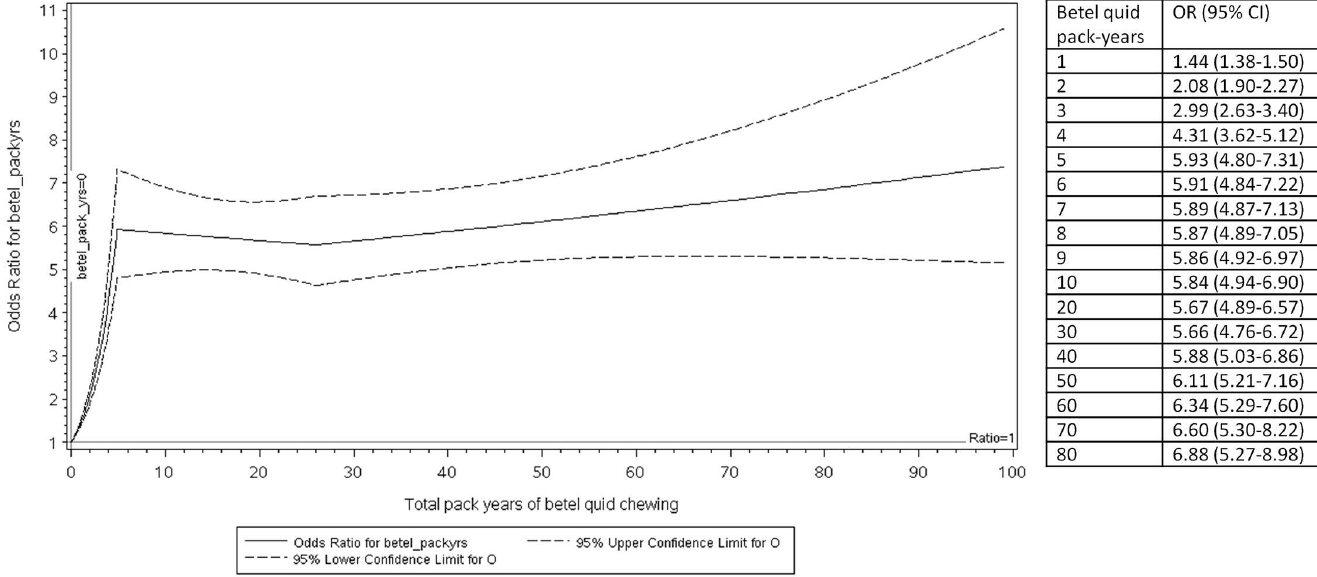
Fig 1. The association between pack-year of betel quid chewing and risk of head and neck cancer. This figure shows the non-linear relationship between pack-year of betel quid chewingand risk of head and neck cancer. The middle solid line represents the odds ratios, the upper dashedline represents the 95% upper confidence intervals, and the lower dashed line represents the 95% lower confidence intervals.